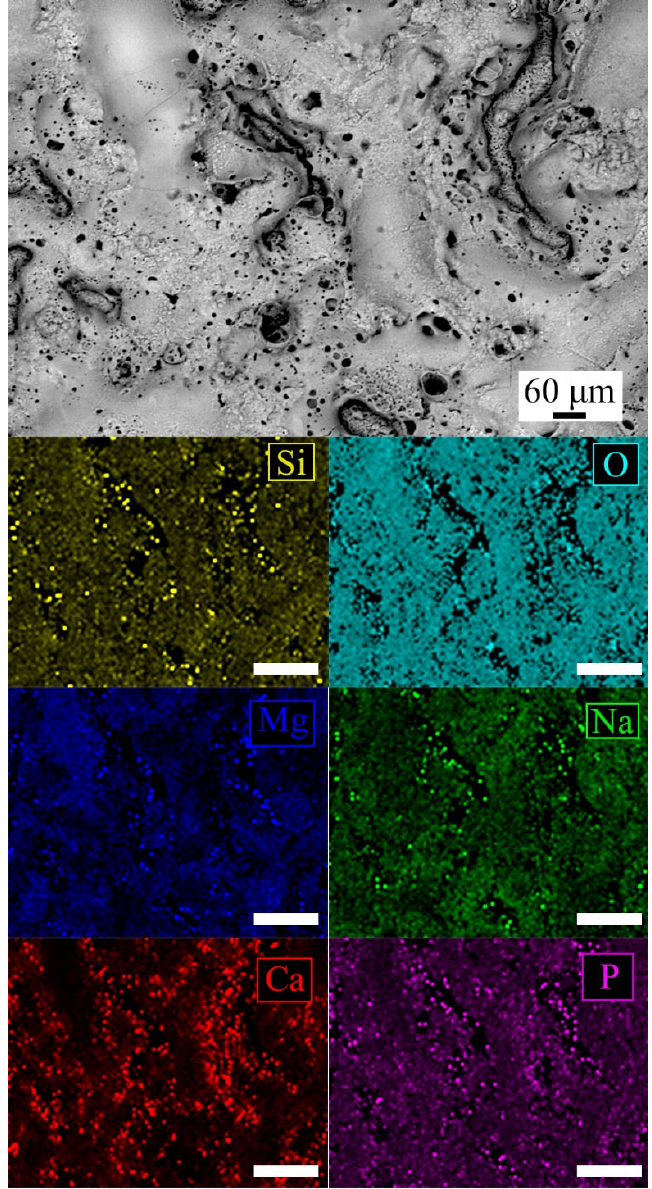
Figure 2. EDS elemental mapping, performed on the surface of the PEO ‐ BIO sample. White lines in the images of the single elements represent 240 μ m.